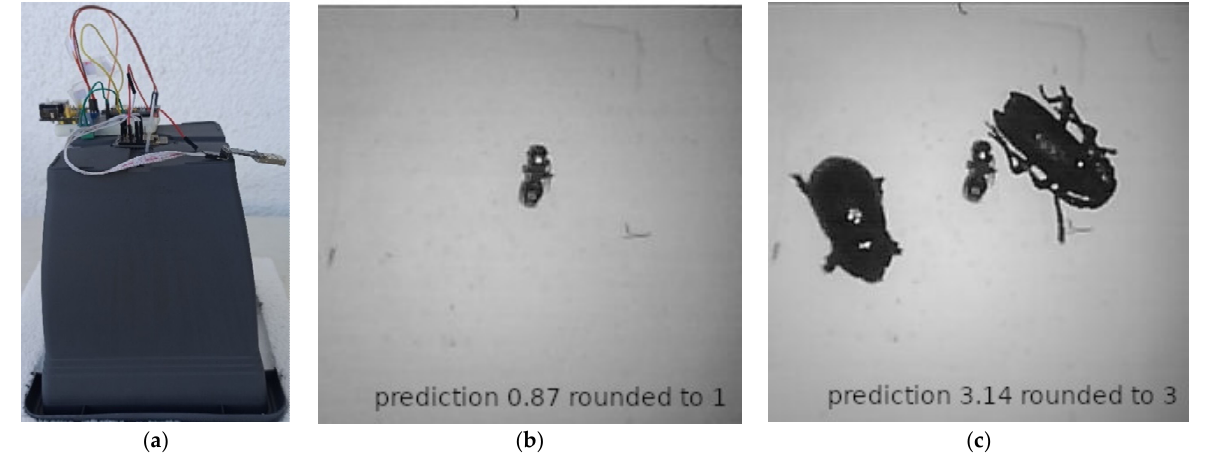
Figure 4. ( a ) The camera-based trap in operational conditions. ( b ) The case of one insect at day T. ( c ) At day T + 1 there are three insects. The difference in inferred counts from day T to T + 1, triggered an alert. Counting does not require a high analysis picture as in an identification task. Note the low quality of the pictures in ( b , c ).